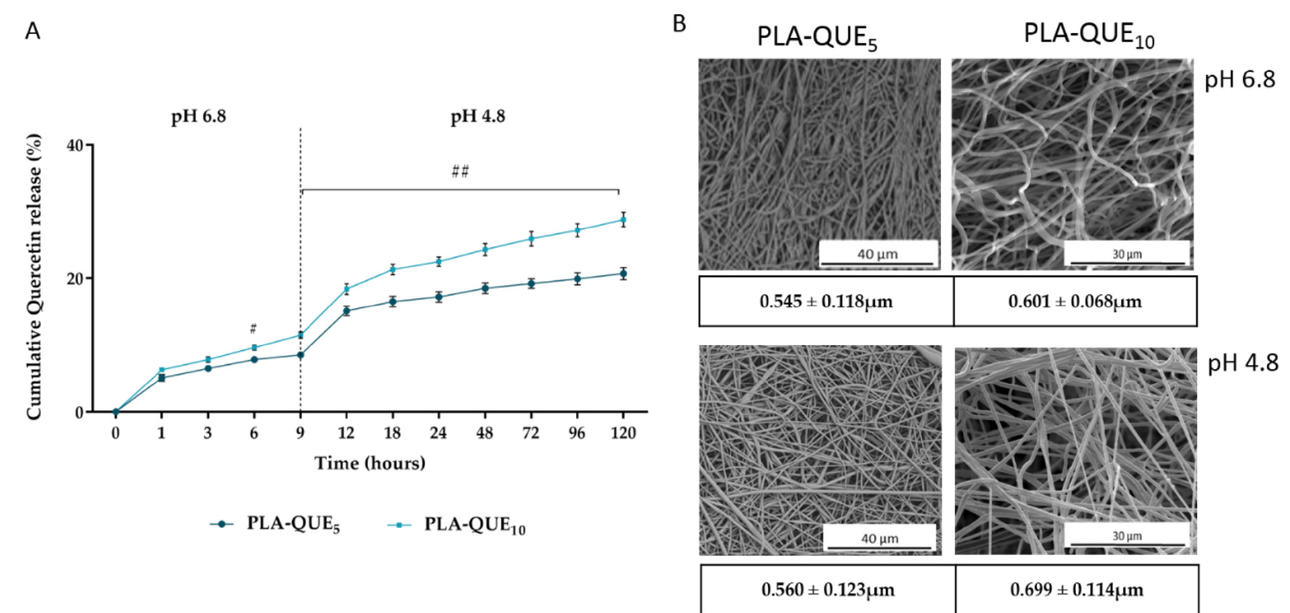
Figure 2. ( A ) Cumulative release profiles of quercetin at 37 °C from PLA-QUE 5 and PLA-QUE 10 incubated in SAGF-suc at pH 6.8 from 0 to 9 h, and at pH 4.8 from 10 to 120 h. For each sample, six different experiments were conducted, and the results are expressed as the mean of the values obtained (mean ± SD). Statistically significant variations: # p < 0.05, and ## p < 0.01 versus PLA-QUE 5 . ( B ) SEM micrographs of PLA-QUE 5 and PLA-QUE 10 fibers and average diameters of PLA-QUE 5 and PLA-QUE 10 fibers after immersion at pH 6.8 and pH 4.8.